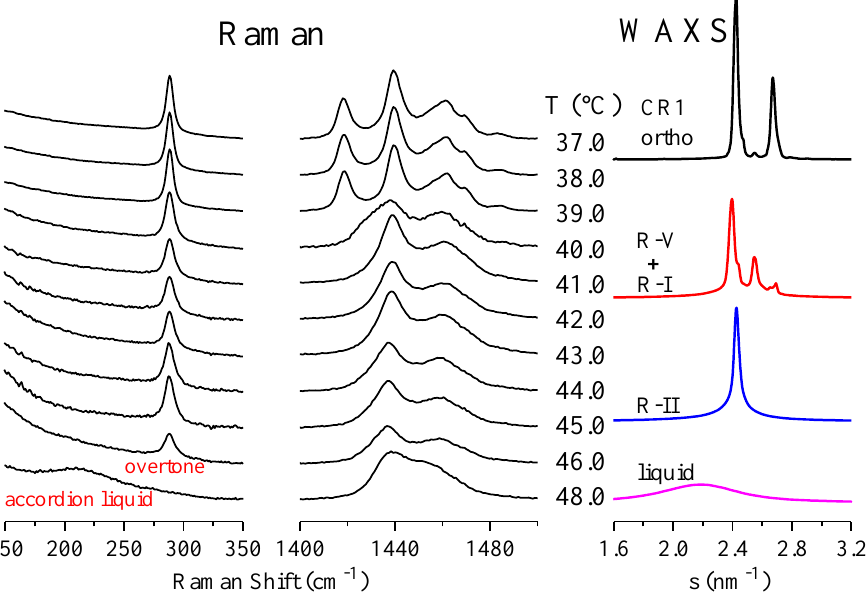
Figure 7. Selected sections of the Raman spectra for sample C 23 H 48 in a step-heating experiment. Left: first overtone (and accordion liquid); middle: CH 2 bend region. For clarity of the presentation, only one out of every two spectra is plotted. The corresponding WAXS diffractograms are also shown at the right.